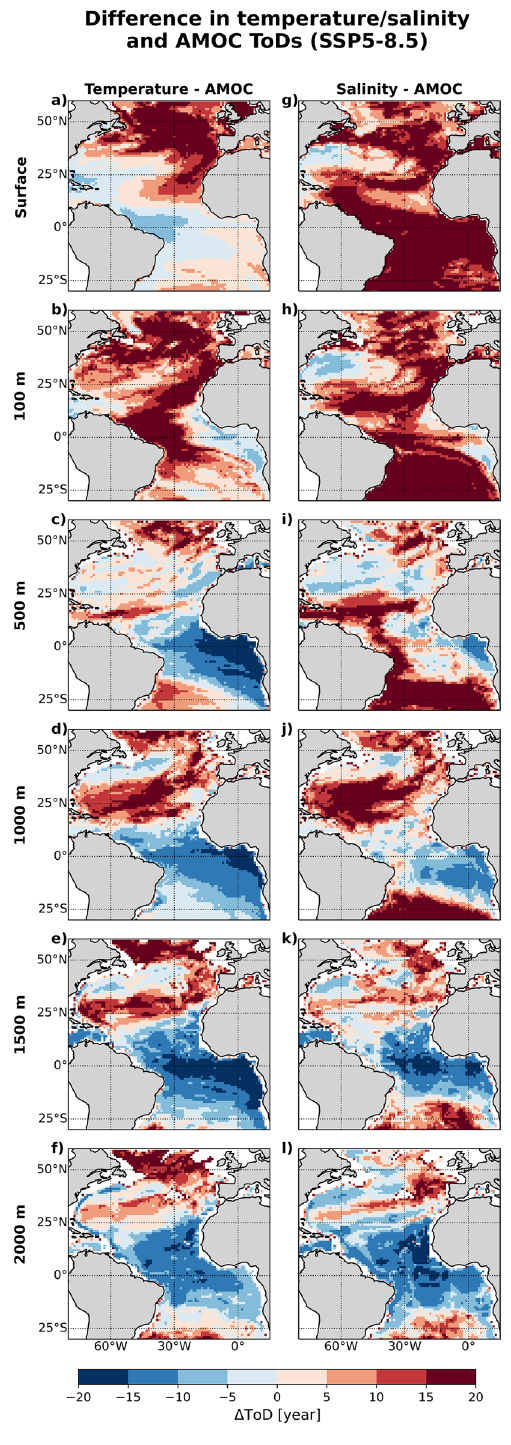
Figure 4. Multi-model mean difference between temperature/salinity and AMOC ToDs under SSP5-8.5 scenario at ( a , g ) ocean surface, ( b , h ) 100 m, ( c , i ) 500 m, ( d , j ), 1000 m depths, ( e , k ) 1500 m, and ( f , l ) 2000 m. Red denotes areas where temperature/salinity changes lag the AMOC signal changes while blue denotes the opposite. Maps were generated with Python 3.9.16 using Matplotlib v3.6.2 (https:// matpl otlib. org/) and Cartopy v0.21.1 (https:// scito ols. org. uk/ carto